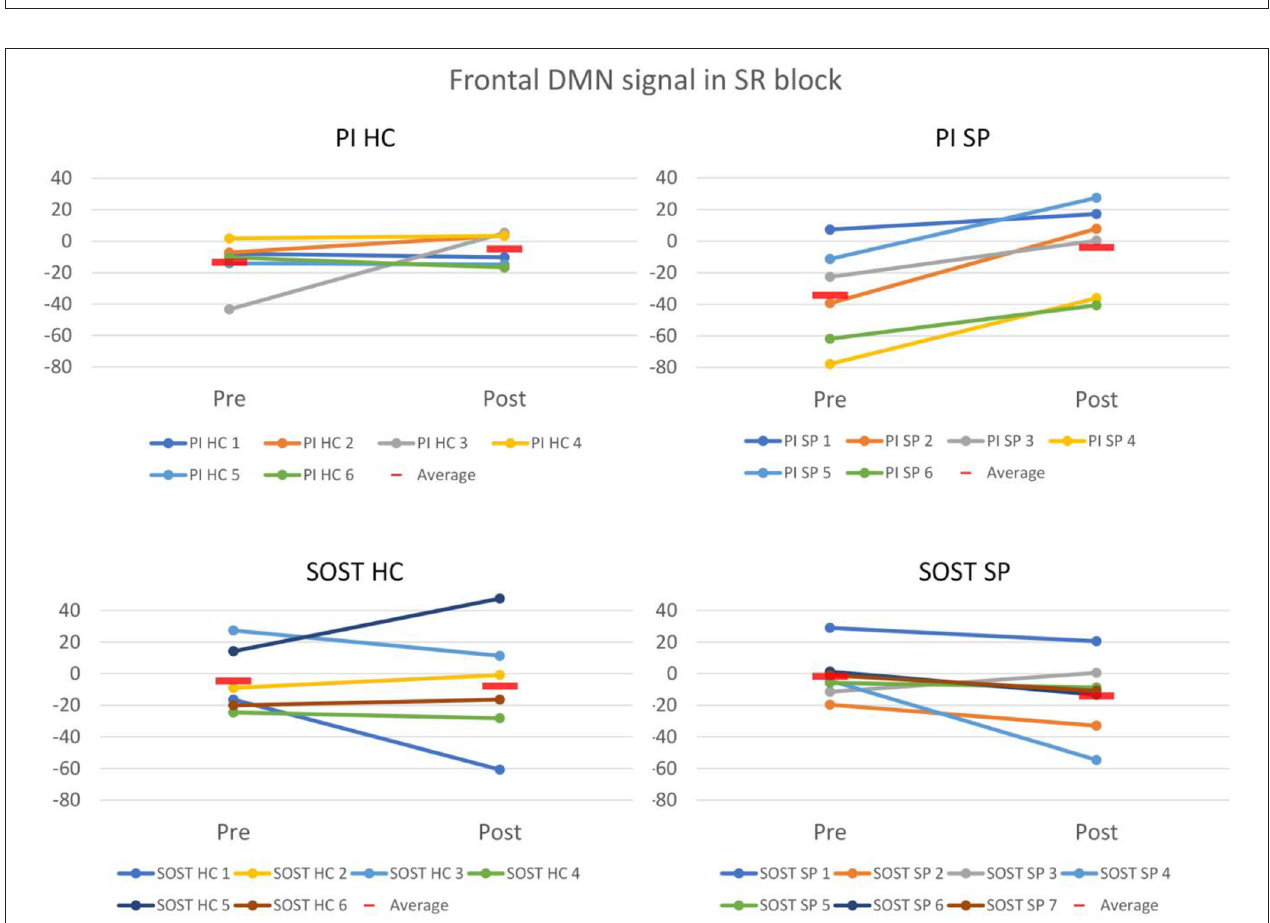
specific compensatory activity, as would be the case for patients. Therefore, proper deactivation of the DMN might be important for patients with lesions in left frontoparietal areas, in order